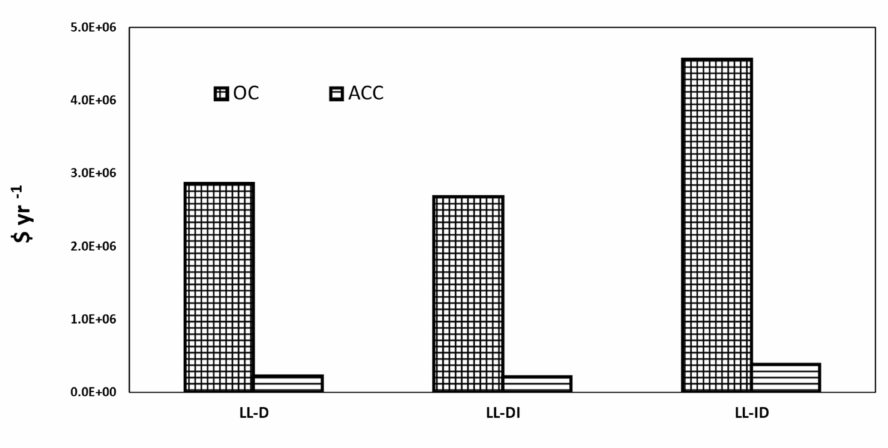
Figure 2. Operative and annualized capital costs for the configurations of Figure 1 reaching the purity targets.